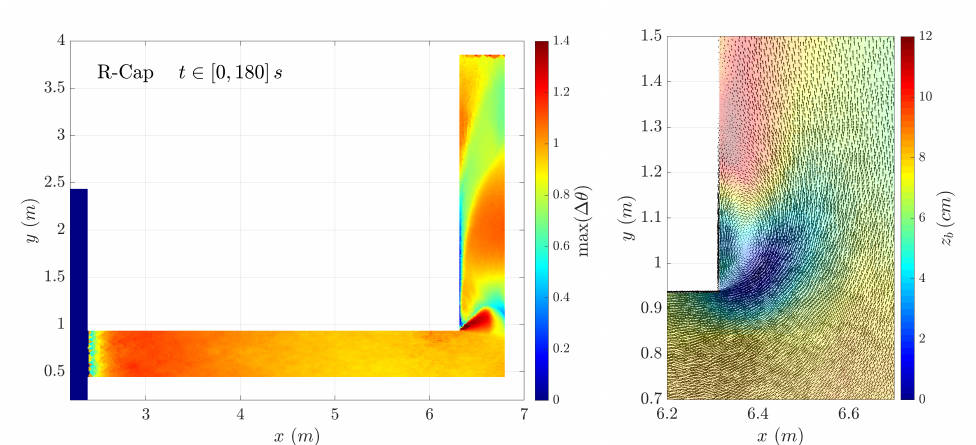
Figure 6. Flow structure with the R-Cap model: ( left ) 2D map of the maximum ∆ θ ; ( right ) zoom of the inner corner region. The velocity vectors are superimposed with the bed